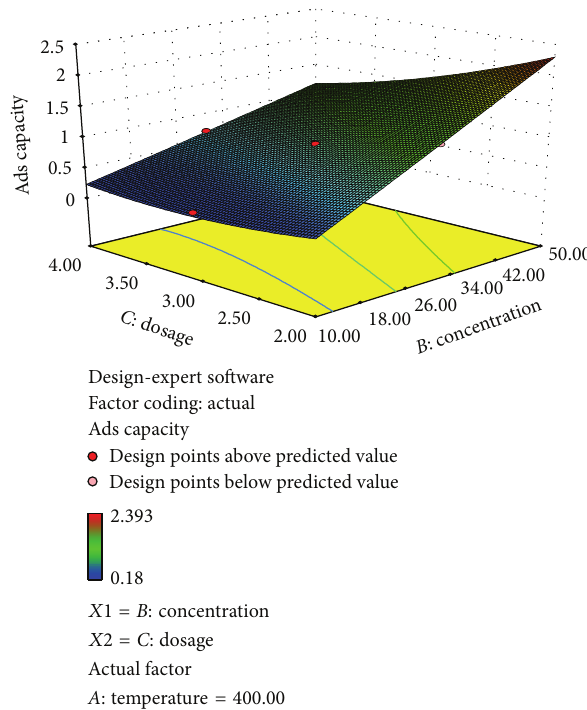
Figure 6: Combined effect of factors 𝐴 - 𝐶 on response 𝑌 2